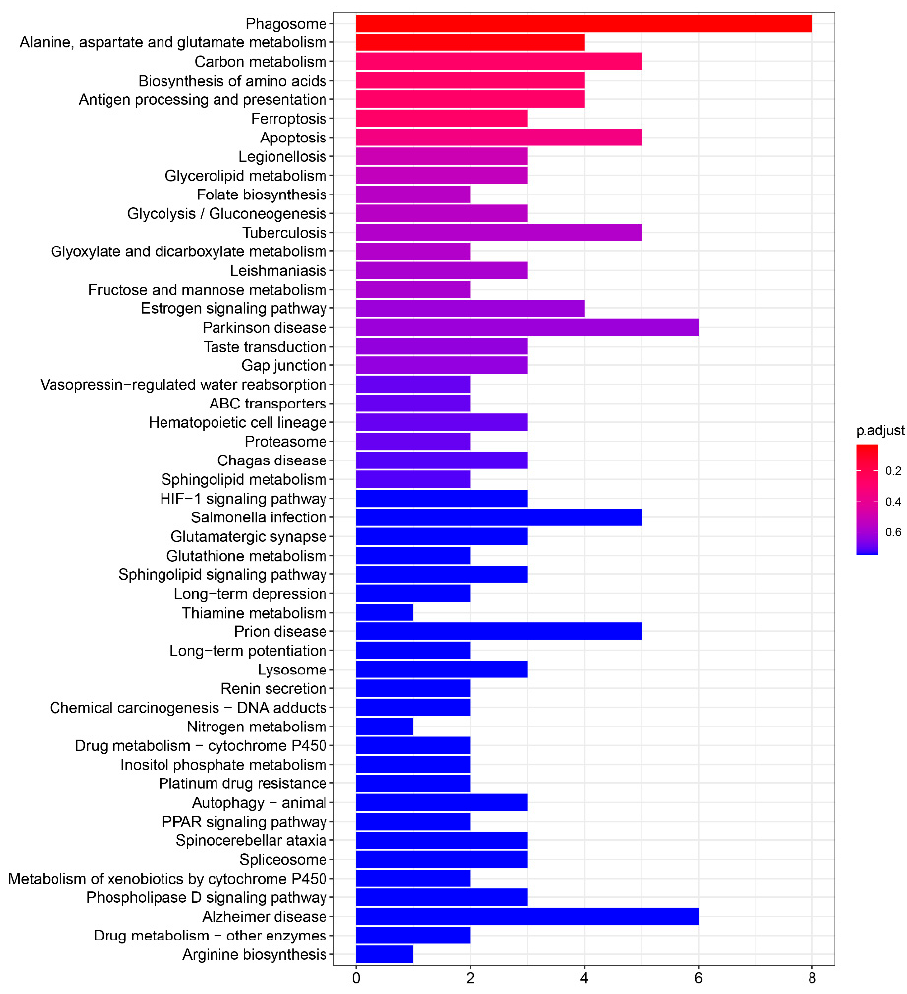
Figure 8. The top 50 enriched KEGG pathways.